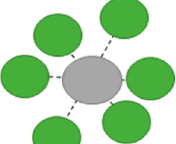
Figure 5. Structure of Pd(II), Au(III), and Pt(IV) chlorocomplexes. Figure was made by authors.